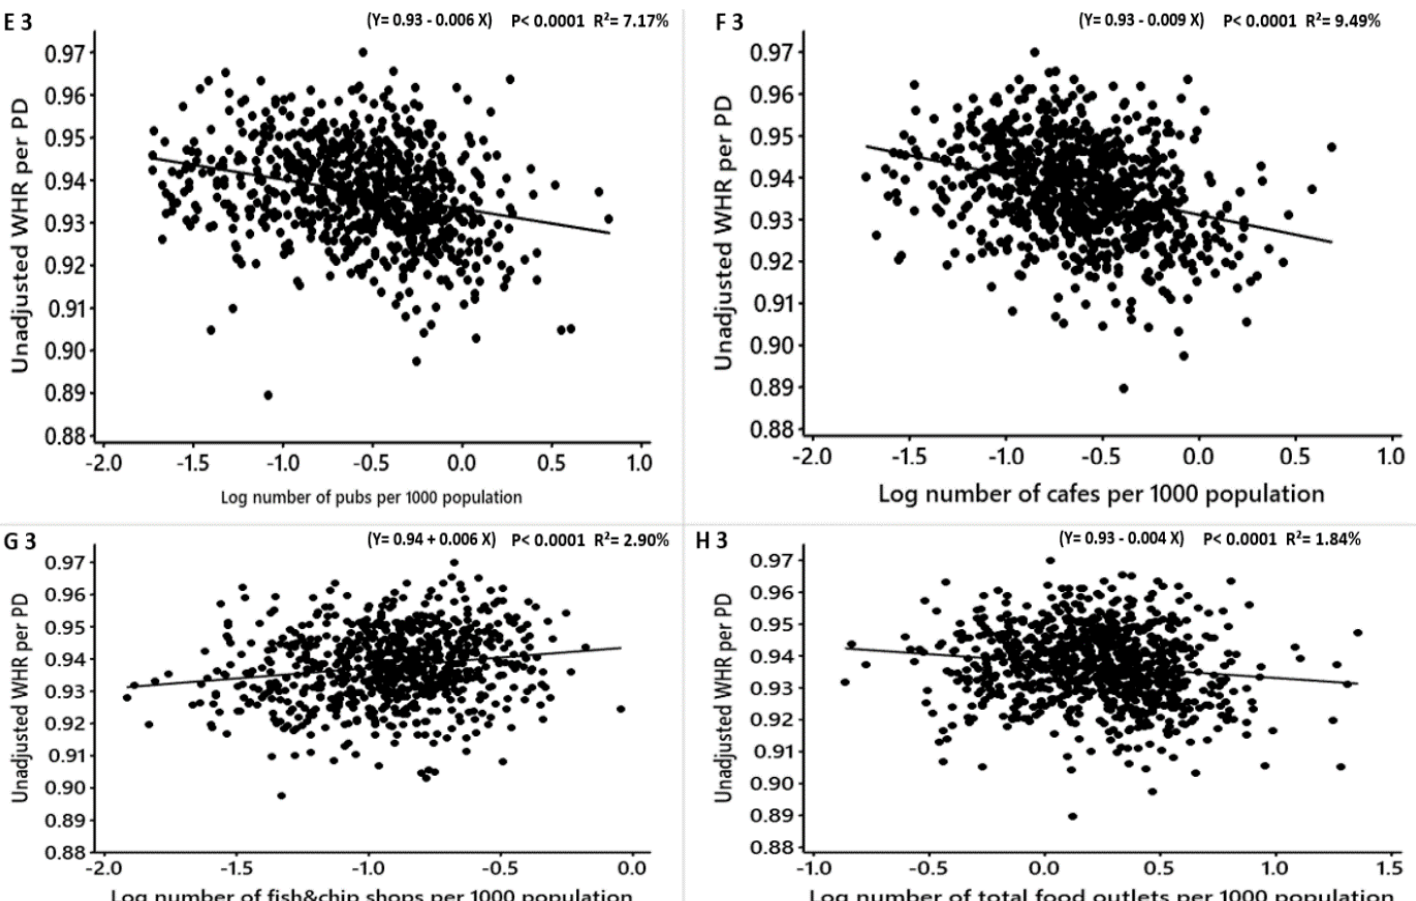
Figure 1. Males: Linear regression analysis of the association between log-transformed numbers of food outlets per 1000 population and unadjusted obesity measure. BMI = Body Mass Index, WHR = Waist to Hip Ratio. FFR = Fast-Food Restaurants, FSR = Full-Service Restaurants, total food outlets = combined.